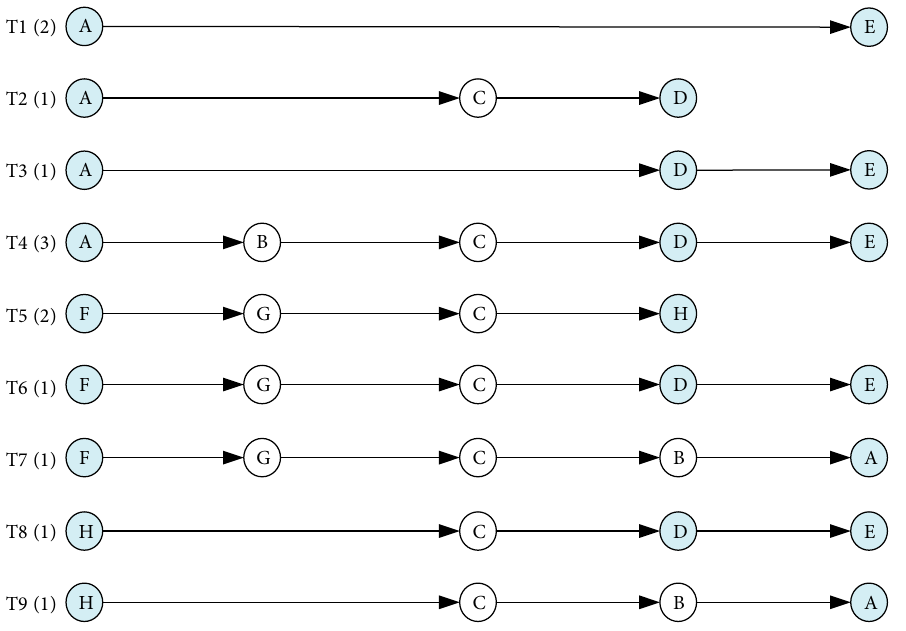
Figure 3: Train service